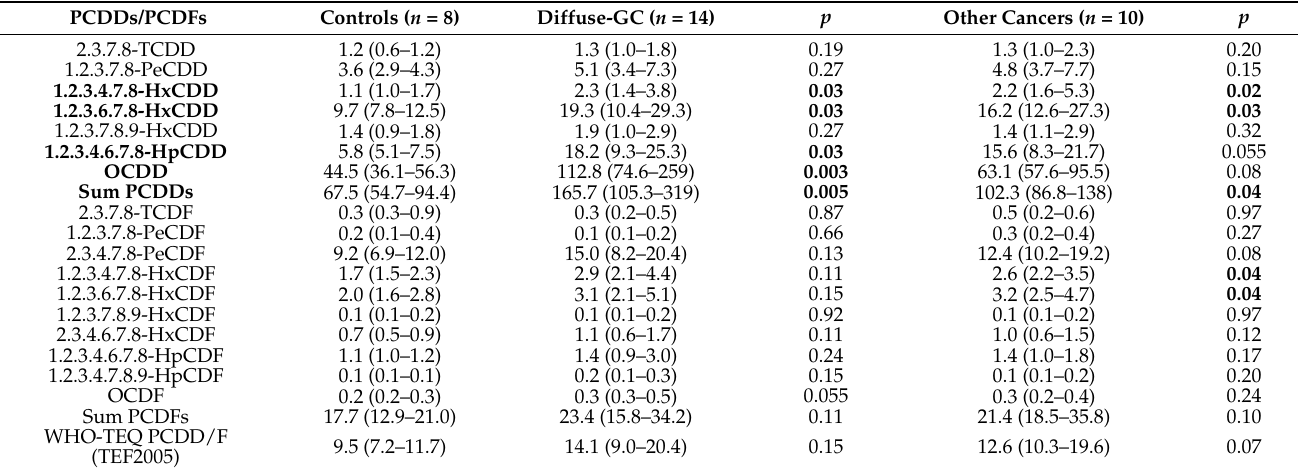
Table 2. Summary of polychlorinated dioxins/furans (PCDDs/PCDFs) distributions and detection frequencies (DF) measured in omental fat from cases of diffuse-gastric cancer, other cancers with peritoneal metastasis, and non-cancer as control patients. Results are represented by median (interquartile range) (pg/g lipid). The case groups were compared to the control group with the Mann–Whitney U test (* p < 0.05; ** p < 0.01).